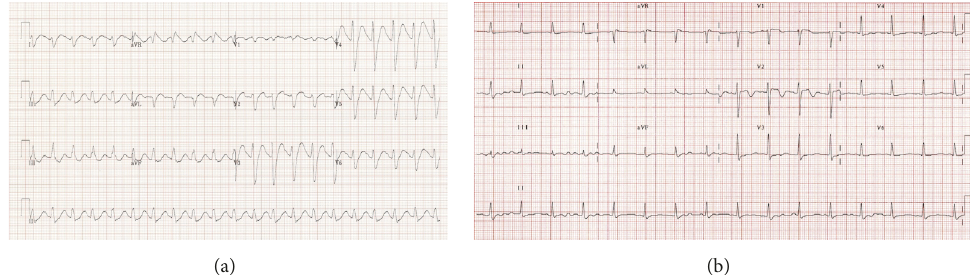
Figure 2: (a) Sodium channel toxicity on 12-lead ECG (taken from https://lifeinthefastlane.com). On this 12-lead ECG you can see regular wide QRS tachycardia with no clear P waves, right axis deviation, tall R wave in AVR, and poor R wave progression in precordial leads. (b) Sodium channel toxicity on 12-lead ECG after administration of sodium bicarbonate (taken from https://lifeinthefastlane.com). On this 12-lead ECG after administration of sodium bicarbonate you can see atrioventricular dissociation with normal QRS, normal axis, and resolution of tall R wave in